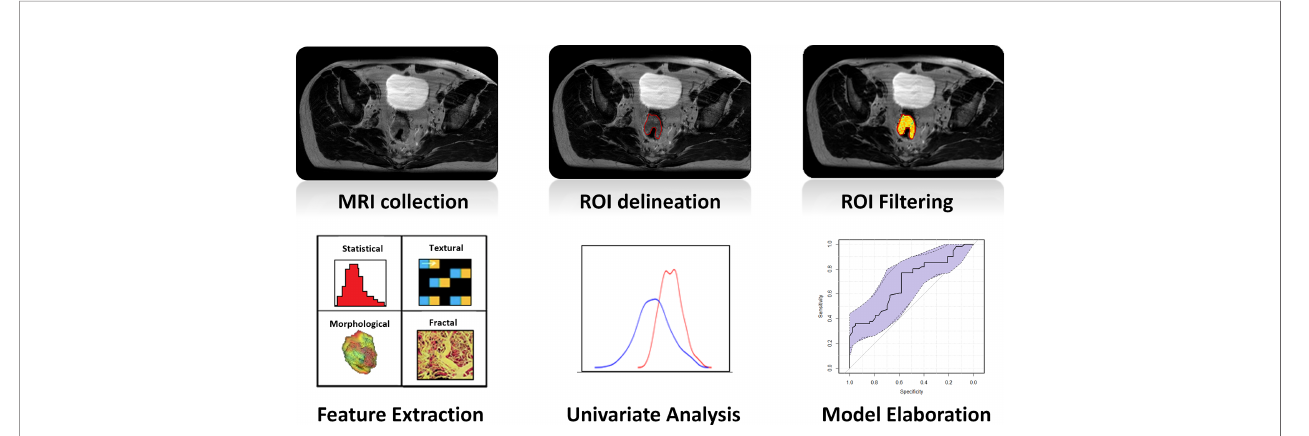
FIGURE 1 | Diagrammatic representation of the whole radiomic process: once MR images were collected, GTV was delineated on each MRI. Images were fi ltered, and four types of radiomic features (statistical, textural, morphological, and fractal) were extracted. The ability of every single feature in predicting the outcome was evaluated in terms of the Wilcoxon – Mann – Whitney test, and a logistic regression was calculated considering the most signi fi cant feature. The last two steps were repeated separately for the two cohorts of patients of the study (OXA and no-OXA). GTV, gross tumor volume; OXA,